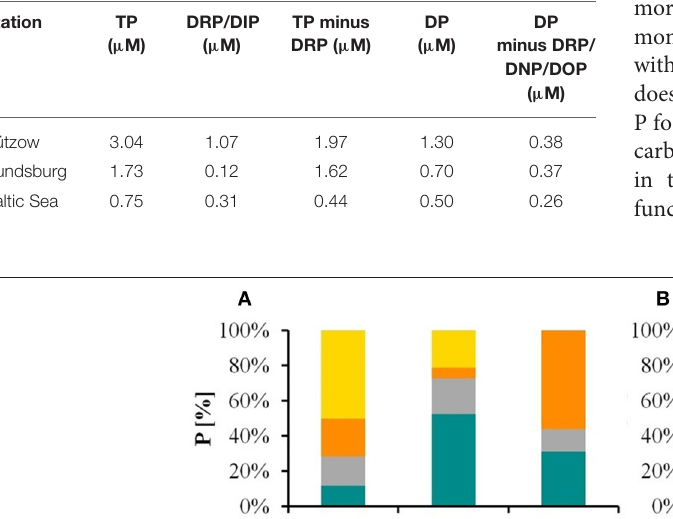
TABLE 3 | Differences of TP and DRP/DIP as traditional monitoring parameter in comparison with differences of DP and DRP (DNP/DOP) at the three stations of the study area as mean values from September 2016 to 2017.